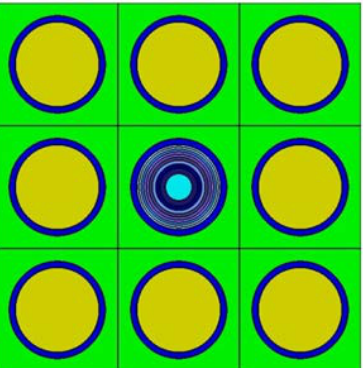
Figure 2. SCALE-6.2 model of BWR 3 by 3 array with Gd-poisoned rod in the centre.